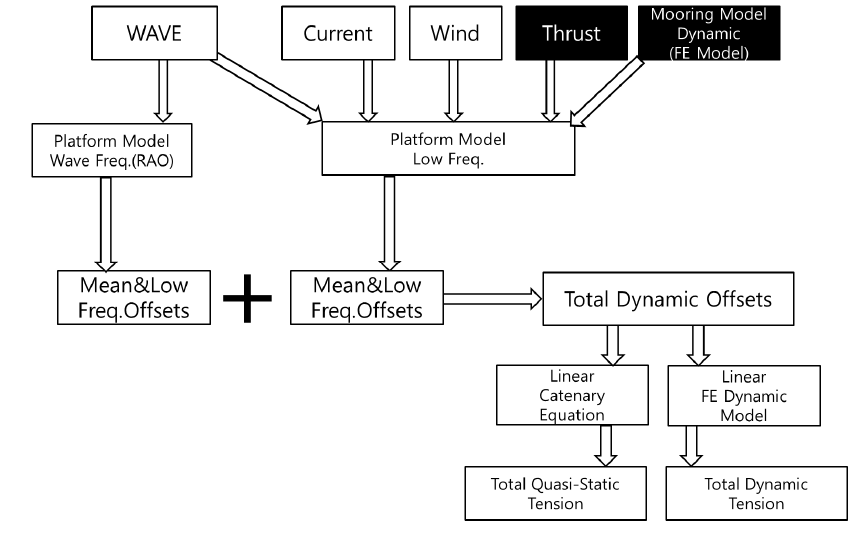
Energies 2018 , 11 , x